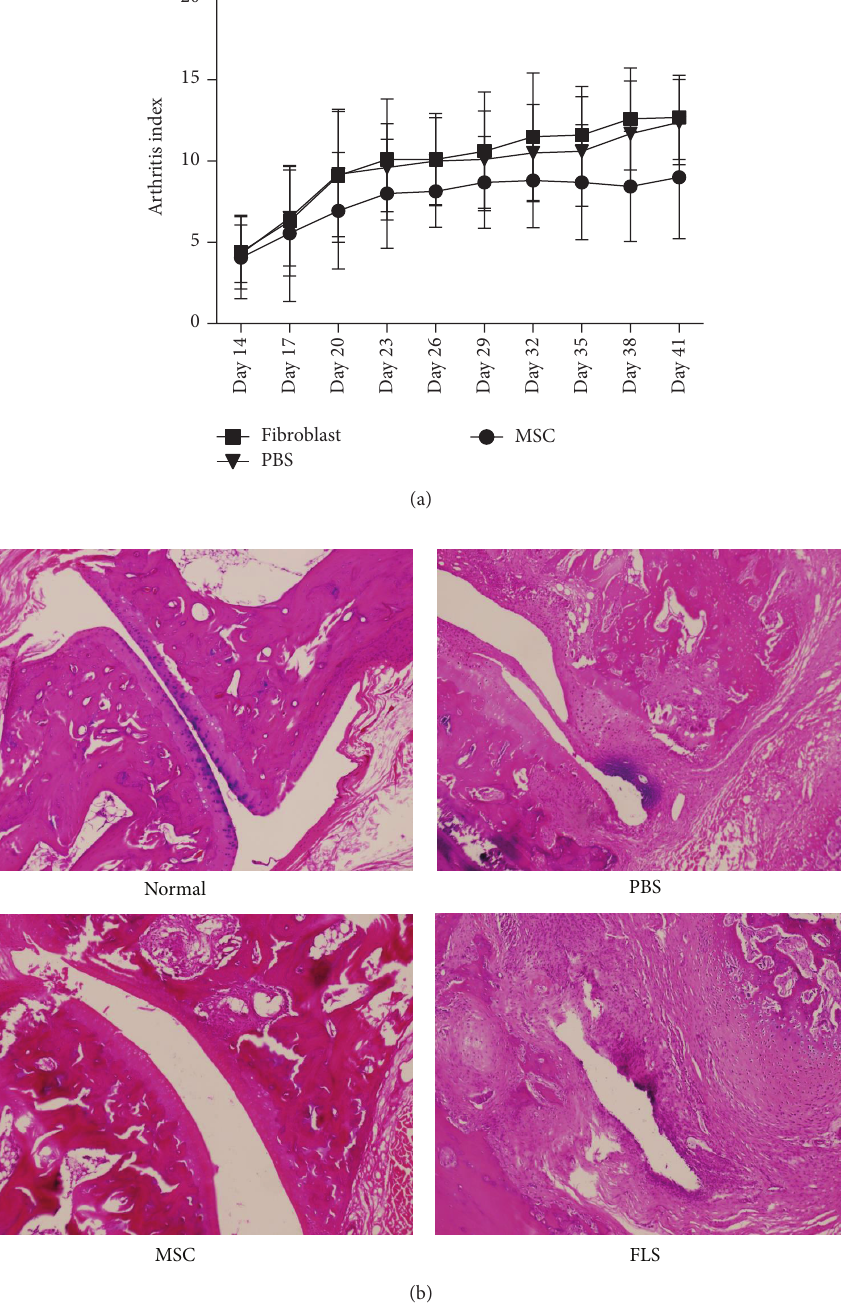
Figure 5: UCMSC prevented tissue damage in CIA. (a) The severity of CIA was progressively attenuated in UCMSC treated rats, as compared with PBS and FLS treated rats. 𝑃 < 0.05 . (b) H&E-stained sagittal sections of joints from CIA rats. PBS and FLS treated rats showed a marked severesynovitisandcartilageerosion.However,themajorityofjointsfrommiceinjectedwithUCMSChadnormalmorphologywithasmooth articulation cartilage surface. Magnification, 100x. UCMSC: umbilical cord-derived mesenchymal stem cell; FLS: fibroblast-like synoviocytes; CIA: collagen-induced